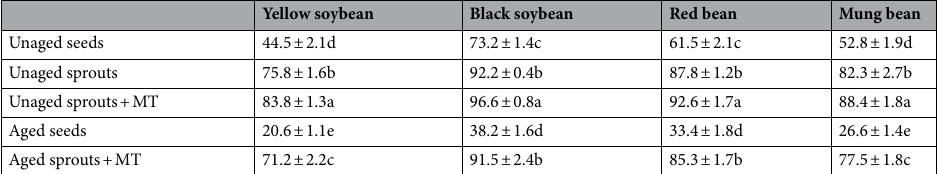
Table 3. DPPH radical scavenging capacity. DPPH radical scavenging capacity (% inhibition) was measured in control and aged bean seeds and sprouts germinated from melatonin-treated aged seeds. Means within the same column (n = 3) followed by the same letter are not significantly different ( p < 0.05). “(un)aged sprout” refers to the germinated seed and sprout from an (un)aged seed. MT melatonin.